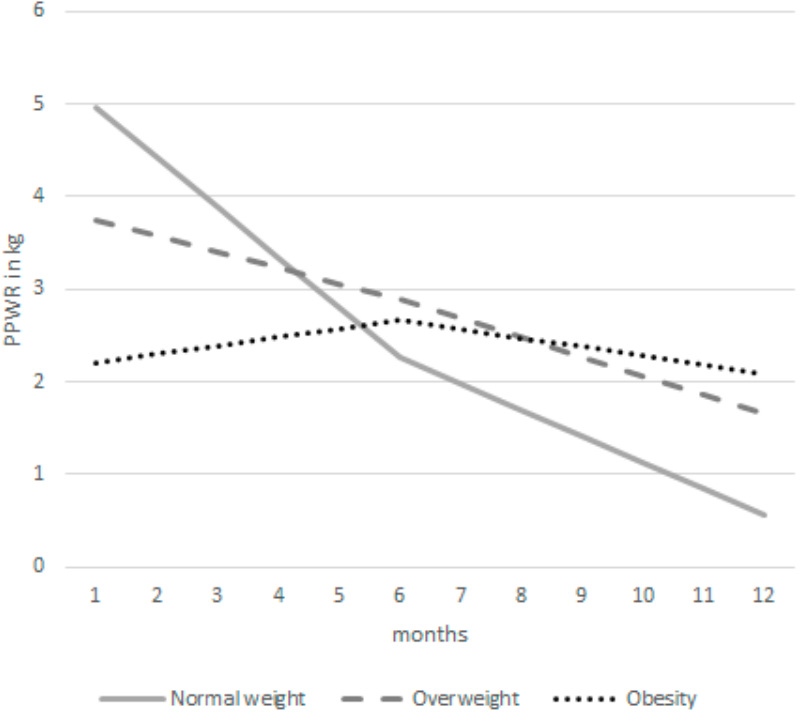
Figure 2. The estimated evolution of postpartum weight retention among women with normal weight, overweight and obesity based on the multivariate mixed model (N = 524 at 6 weeks, N = 395 at 6 months, N = 311 at 12 months postpartum).